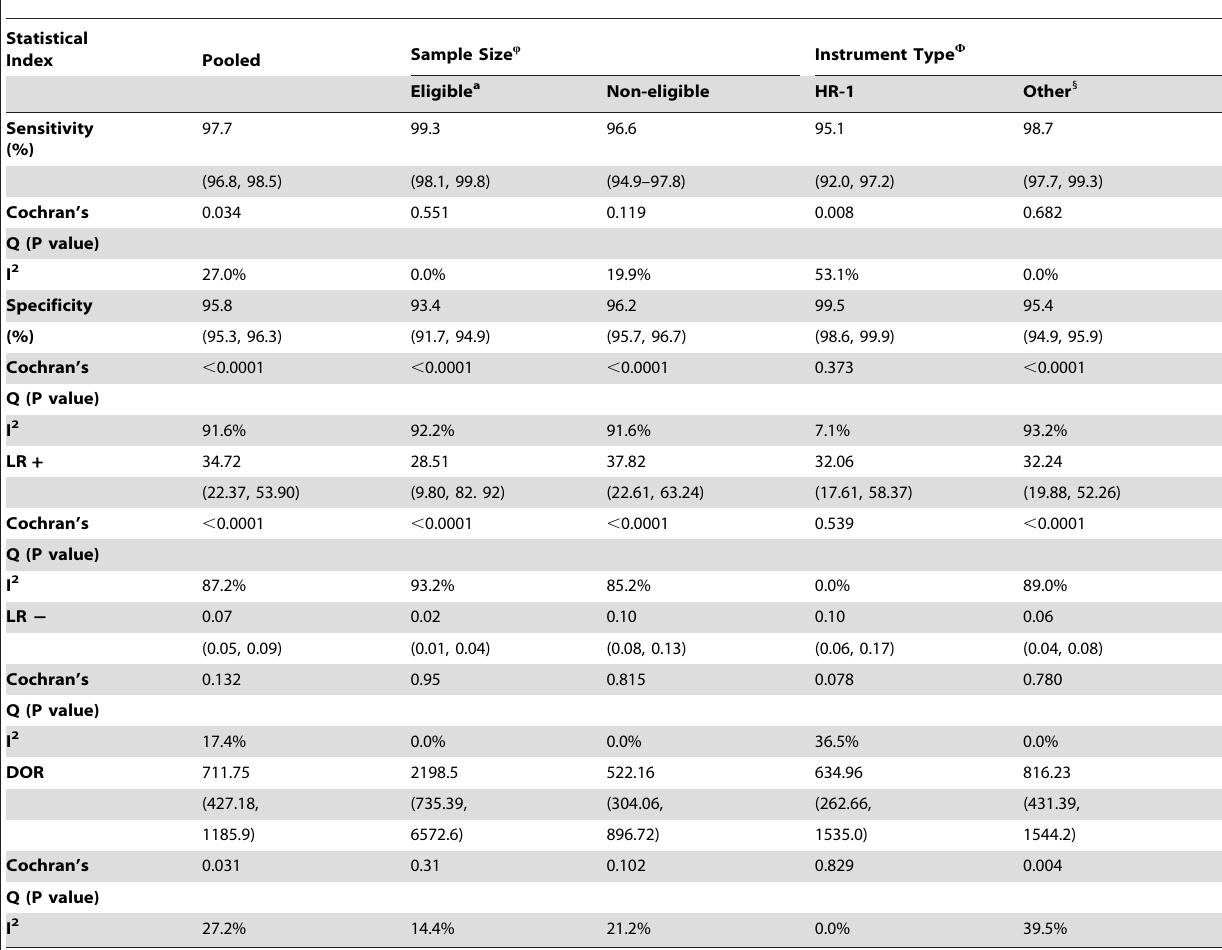
Table 3. Summary results of the pooled and subanalysis by meta disc